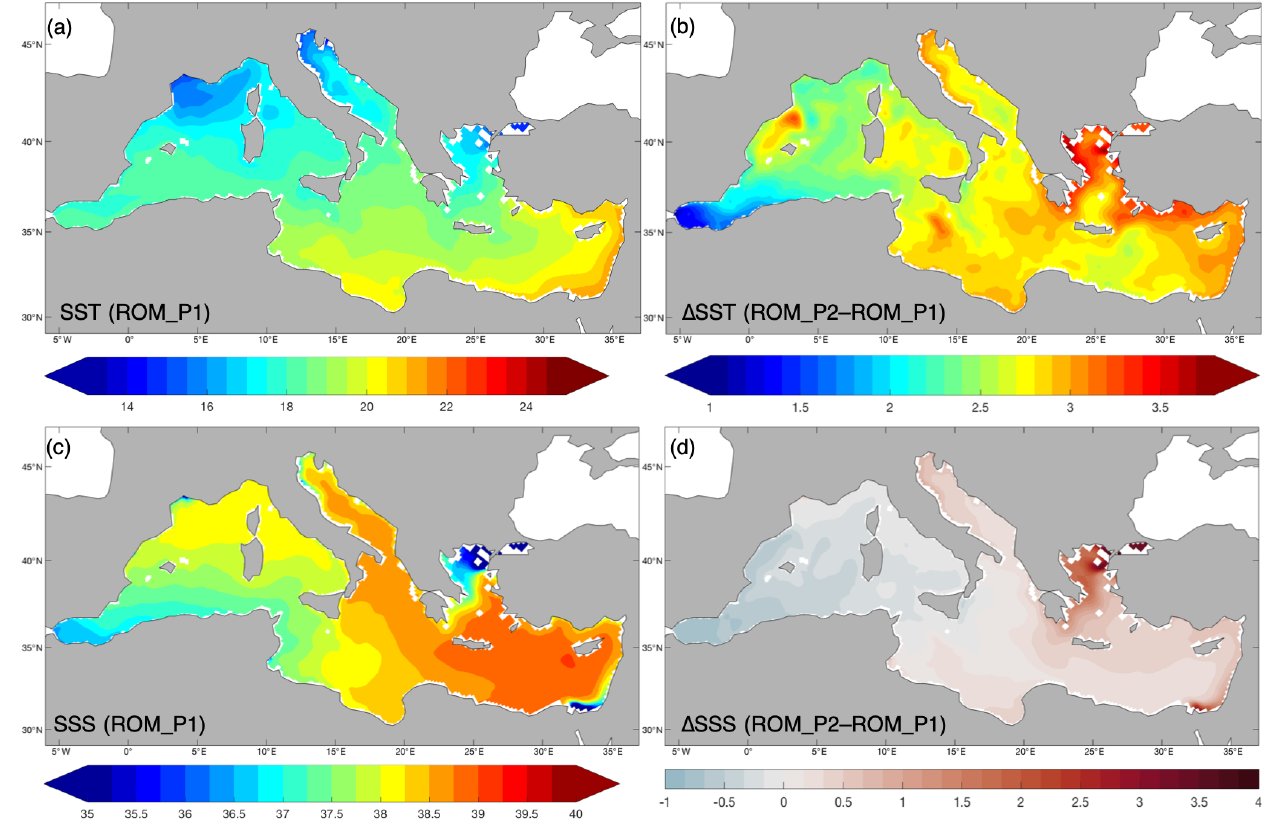
Figure 13. Mean SST ( a , in ◦ C) and SSS ( c , in psu), averaged over the 1976–2005 period (ROM_P1). Differences between mean SST ( b , in ◦ C) and SSS ( d , in psu) in RCP8.5 projection (2070–2099, ROM_P2) and present climate (1976–2005,